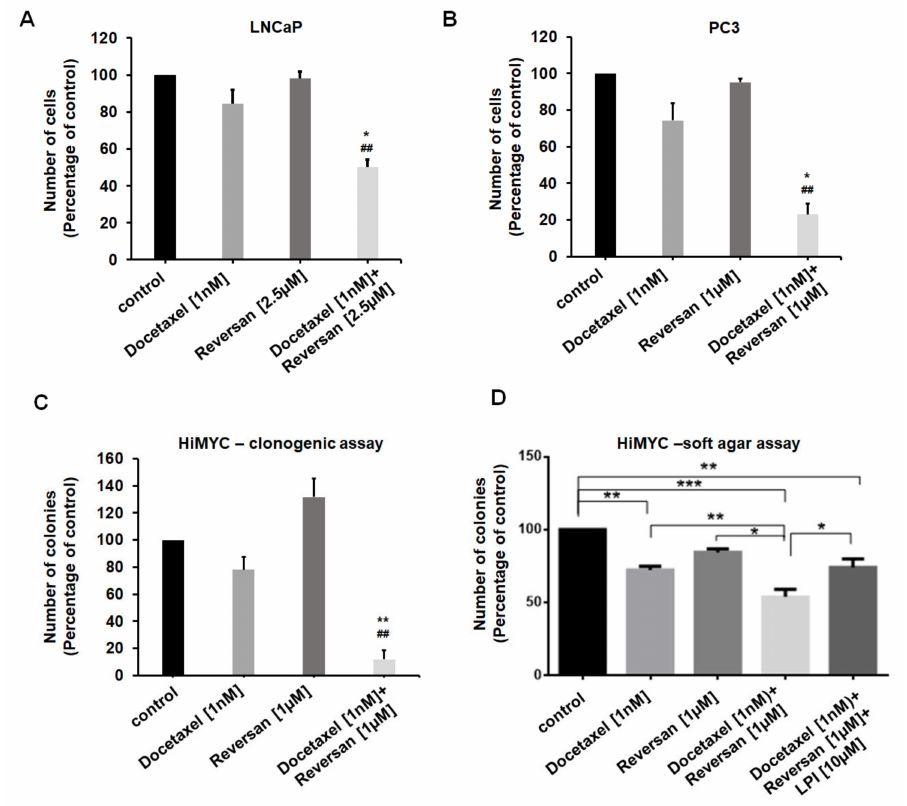
Figure 6. E ff ect of combinations of sub-optimal concentrations of Reversan and Docetaxel on prostate cancer cells growth. LNCaP ( A ) and PC3 ( B ) cells were treated with the indicated concentrations of Docetaxel or Reversan or combinations of the two drugs. Number of cells was assessed after 72 h by cell counting. * p < 0.05 vs. Docetaxel; ## p < 0.01 vs. Reversan. ( C ) HiMYC cells were plated as single cells in a clonogenic assay and incubated in the presence of Docetaxel, Reversan or a combination of the two drugs at the indicated concentrations. Number of 2D colonies was assessed as specified in the Materials and Methods section. ** p < 0.01 vs. Docetaxel; ## p < 0.01 vs. Reversan. ( D ) HiMYC cells were plated on soft agar and incubated in the presence of Docetaxel, Reversan or a combination of the two drugs at the indicated concentrations. Where specified, LPI was also added. Number of 3D colonies was assessed as specified in the Materials and Methods section. * p < 0.05, ** p < 0.01, *** p < 0.001. In all panels, data are expressed as percentage of results from cells treated with